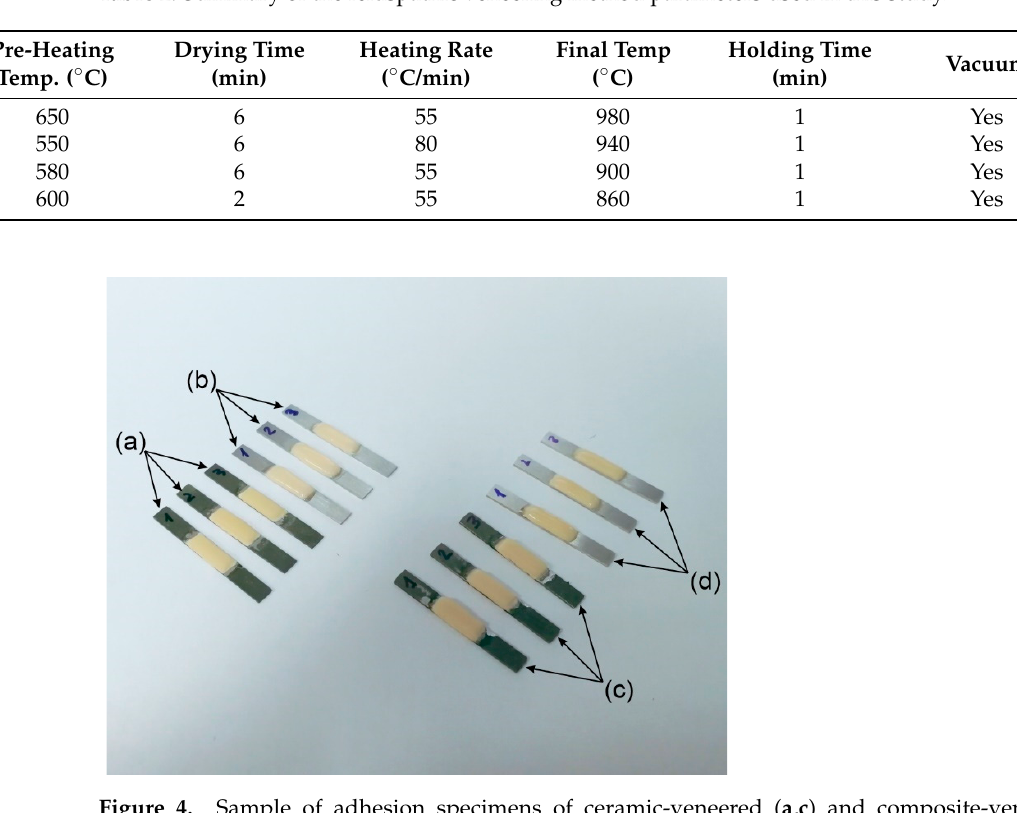
Table 2. Summary of the feldspathic veneering method parameters used in this study.